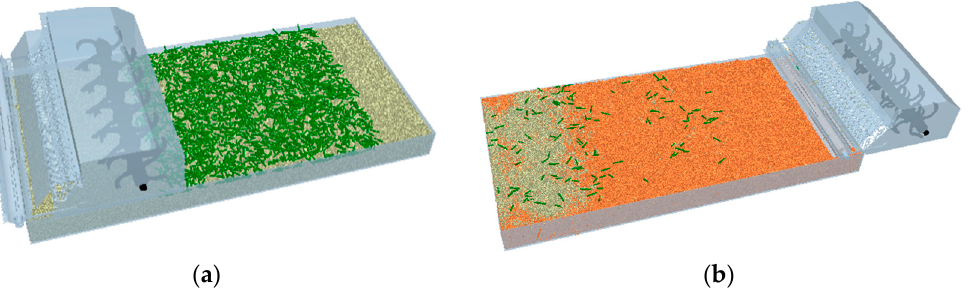
Figure 6. Simulation process of the key components. ( a ) Soil—stem—“separation and burial device” model. ( b ) Simulation process.